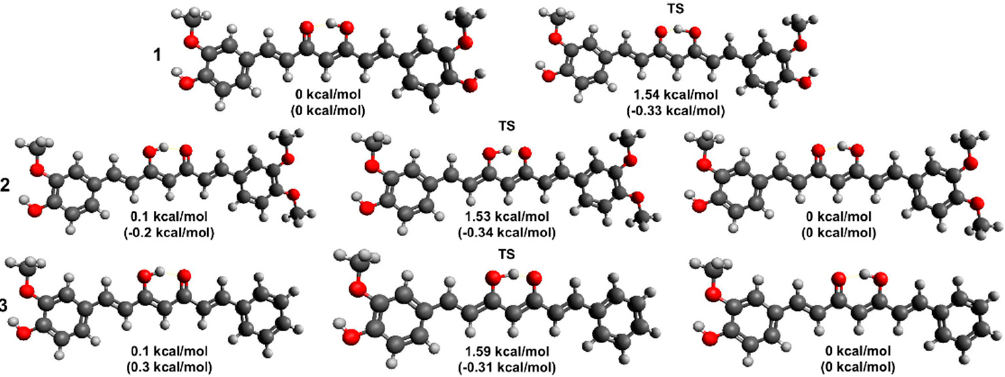
Figure 10. Optimized stationary point geometries and their relative energetics on the ground-state potential energy surface for the enolic tautomers of species 1 , 2 , and 3 , as obtained with the B3LYP/6- 31++G(d, p) level of theory; also shown are the transition state structures (TS) for the proton transfer between the two keto–enolic isomers. For each compound, the lowest electronic energy isomer was chosen as zero for the energy scale. Relative Gibbs’ energy values, estimated via the harmonic oscillator approximation, are also provided (between round brackets); the negative values found for TS geometries are due to shortcomings in the harmonic oscillator approximation.